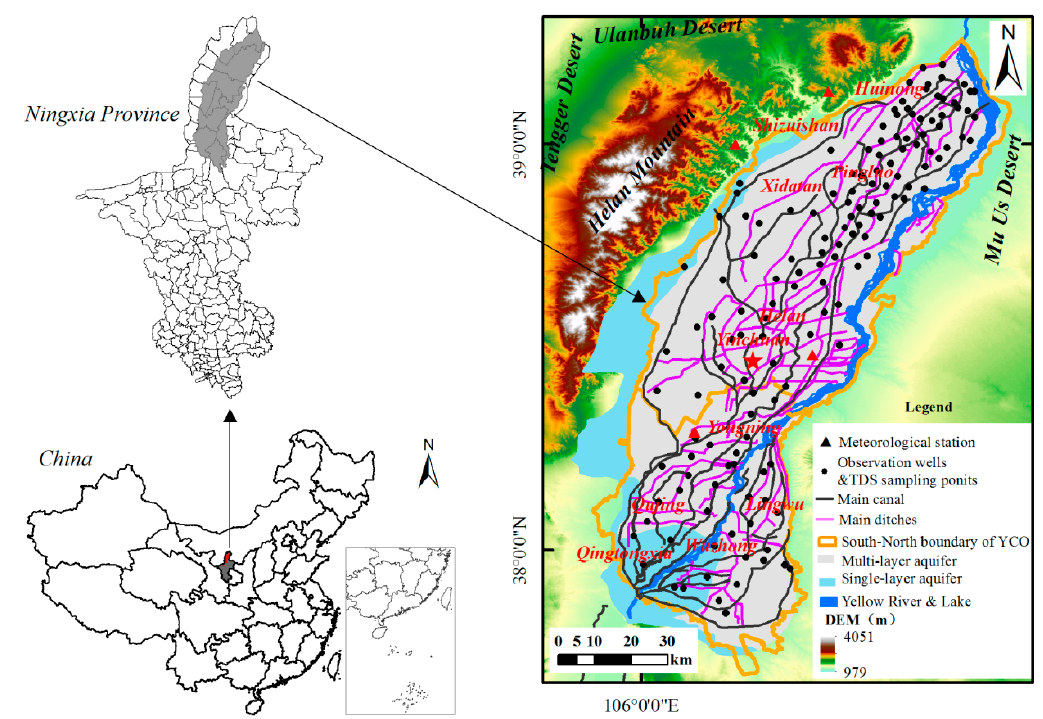
Figure 1. Yinchuan Oasis and the distribution of total dissolved solids (TDS) sampling points.